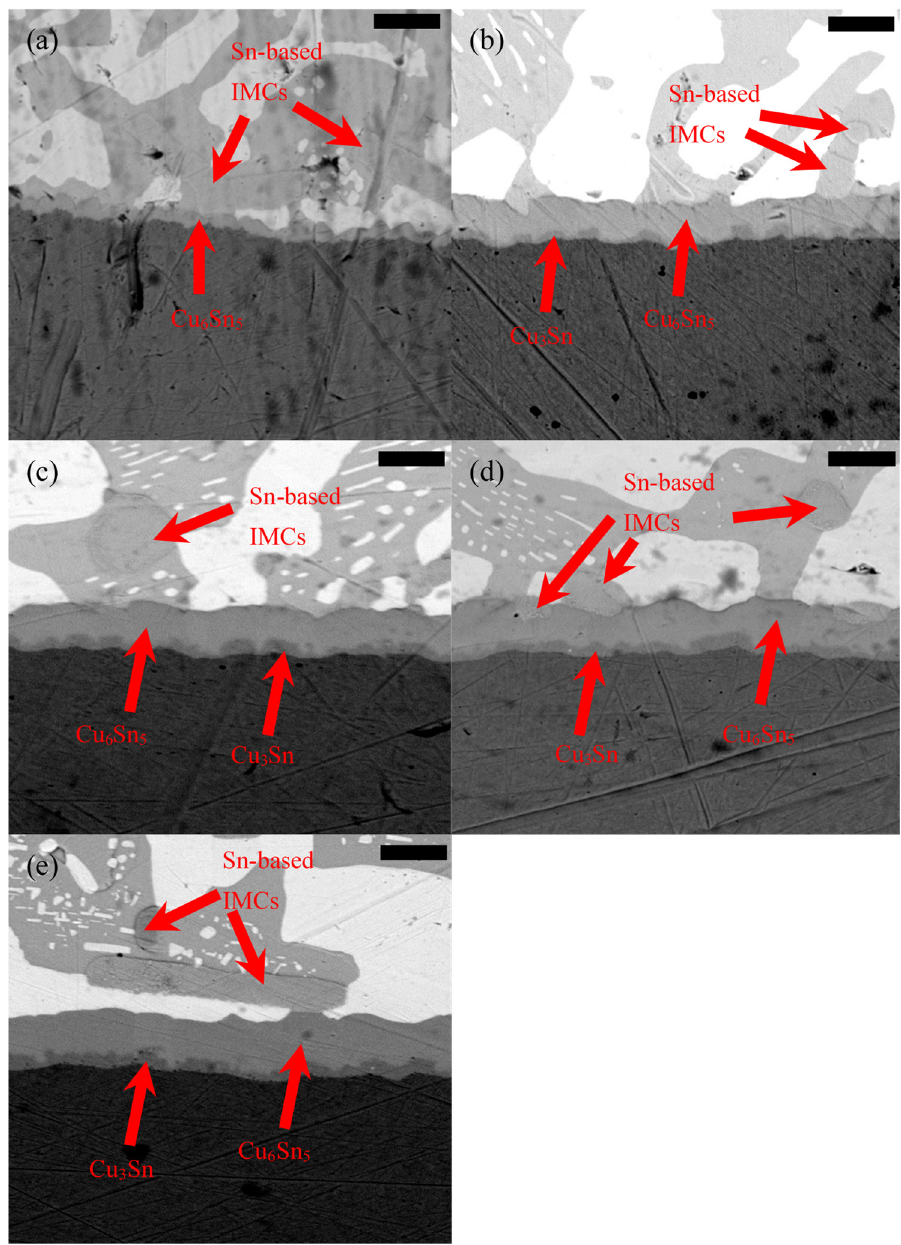
Figure 16. SEM micrograph of LT 47 after ( a ) 0 cycles, ( b ) 250 cycles, ( c ) 500 cycles, ( d ) 750 cycles and ( e ) 1000 cycles. The scale bar is 4 µm in all images.